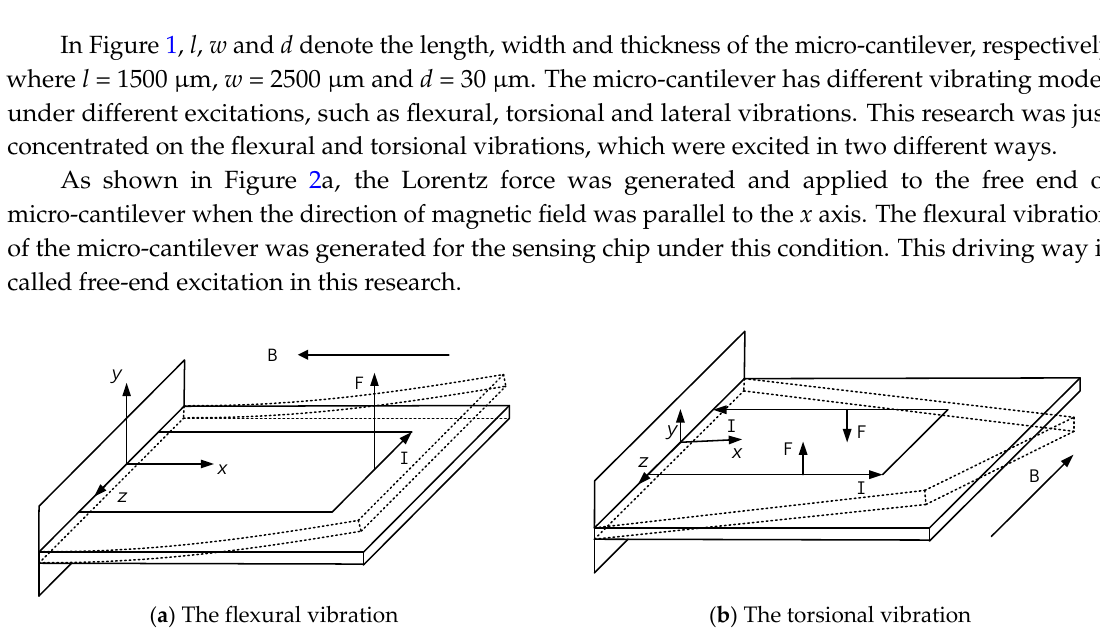
Figure 2. Two different vibrating forms under different excitation ways.